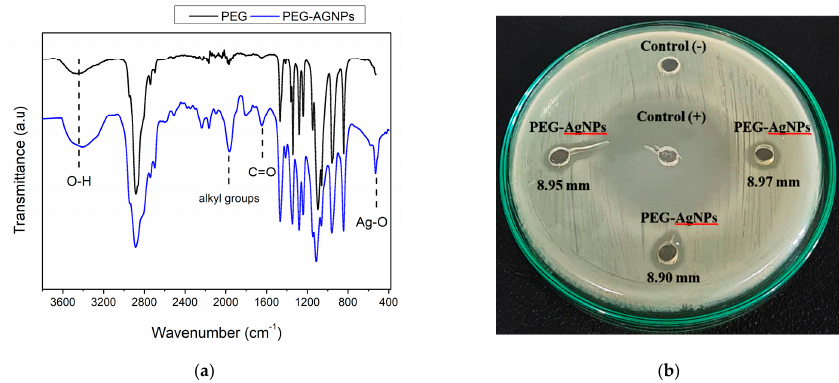
Figure 2. The TEM image of the PEG-AgNPs under different magnifications.